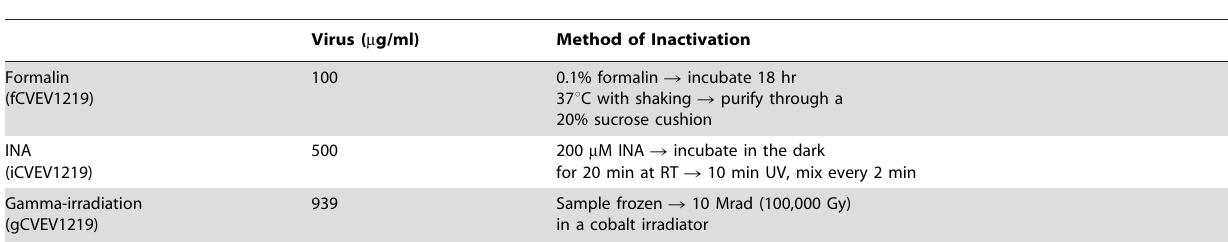
Table 3. Optimized Inactivation Conditions for CVEV1219.